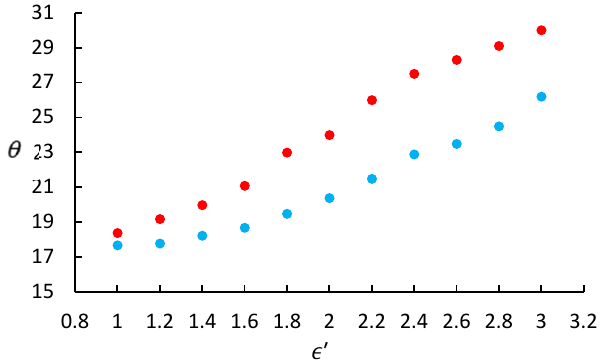
Figure 10. A plot of apparent wake angle 𝜃 against Froude number 𝜖 (cid:4593) for a flow past the Kelvin source, with the source strength 𝐹′ = 0.8 (the red circles) and 𝐹′ = 1.2 (the blue circles).